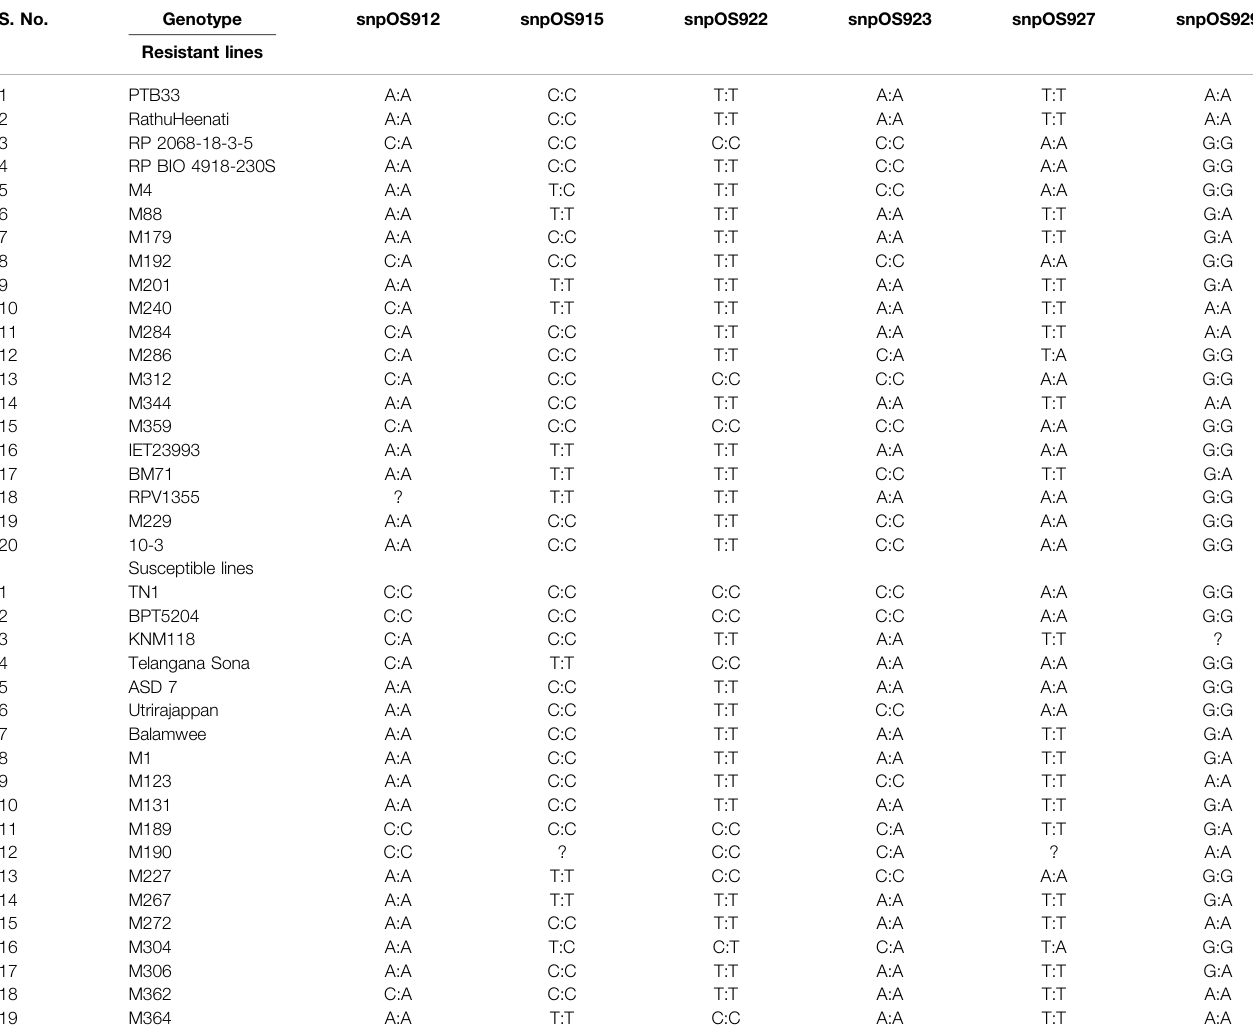
TABLE 7 | Designed SNPs that were able to distinguish resistant and susceptible